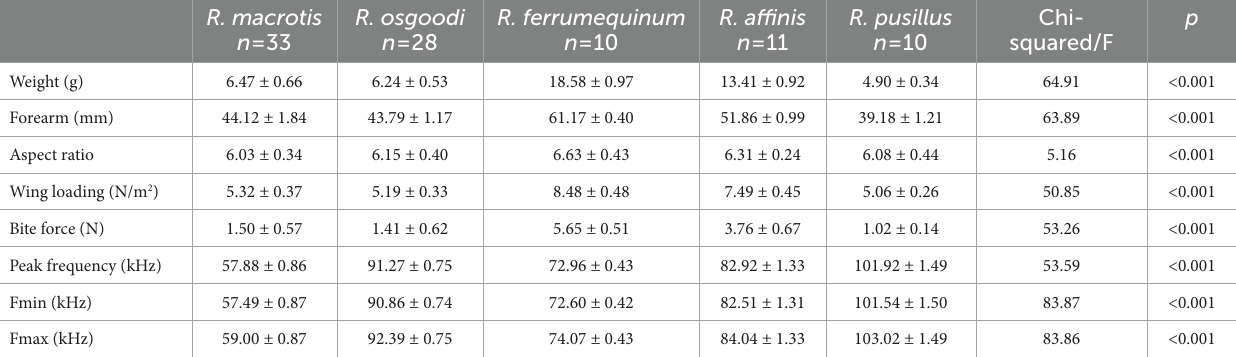
TABLE 3 Results of Kruskal–Wallis (all factors except aspect ratio) and analysis of variance (ANOVA) (aspect ratio) tests examining the variation (mean ± SD) of influencing factors among five bat species. The p-values were adjusted with the Bonferroni correction method for multiple